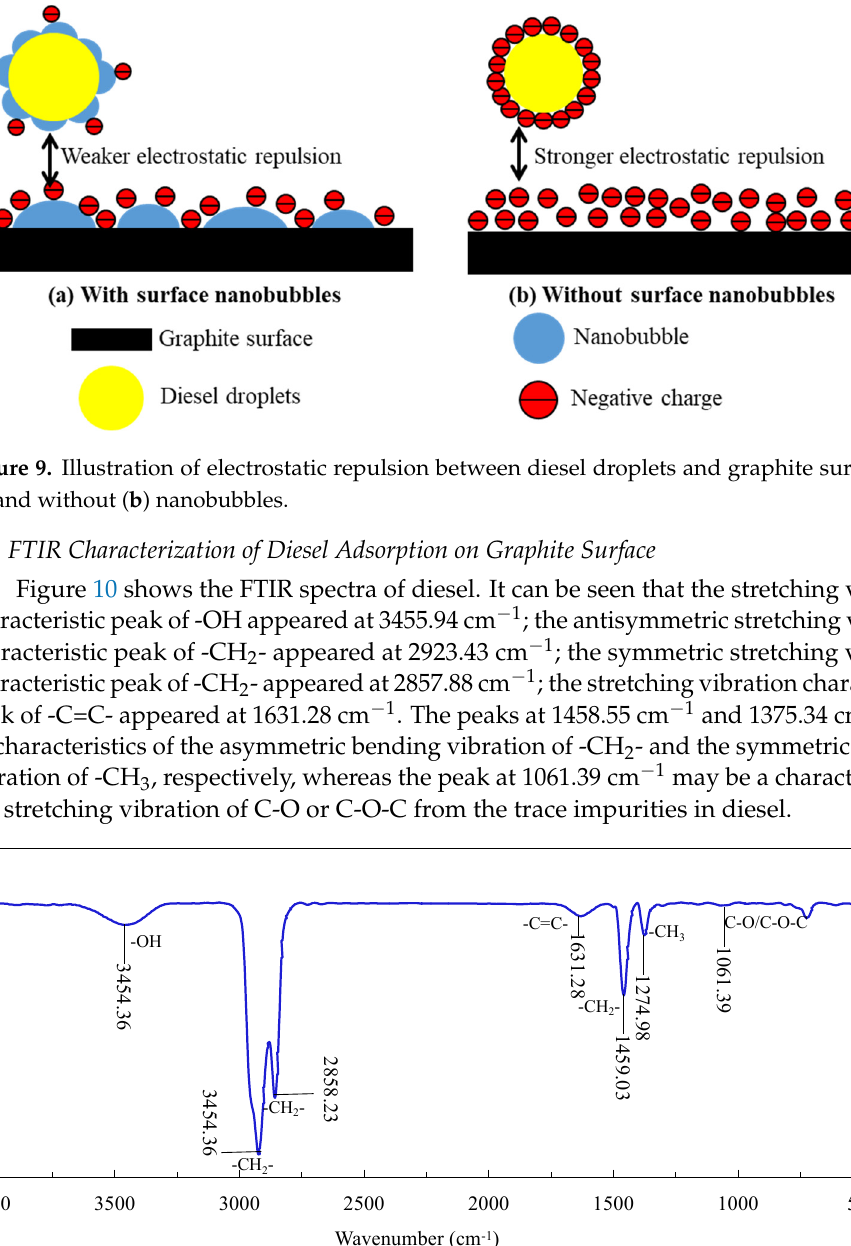
Figure 11. FTIR measurement results of NFC and CFC. The enhanced hydrophobicity of graphite surfaces by nanobubbles is related to the enhanced hydrophobic interaction between the diesel droplets and mineral surfaces. Stockelhuber et al. (2004) reported that the nanobubbles preferentially formed on mineral surfaces could promote hydration film rupture on the mineral interface [43]. Calgaroto et al. (2015) demonstrated that the surface nanobubbles significantly increased the mineral surface hydrophobicity [52]. It should also be mentioned that hydrodynamic cavitation can promote the existence of diesel in the slurry as tiny droplets [50], which can be con- sidered oily bubbles since the surface properties of oil droplets and oily bubbles are es- sentially identical [36]. The extended DLVO theory reveals that hydrophobic attraction is the major driving force behind the mineralization of oily bubbles through the adhesion of hydrophobic mineral surfaces [36], and a more hydrophobic mineral surface results in a